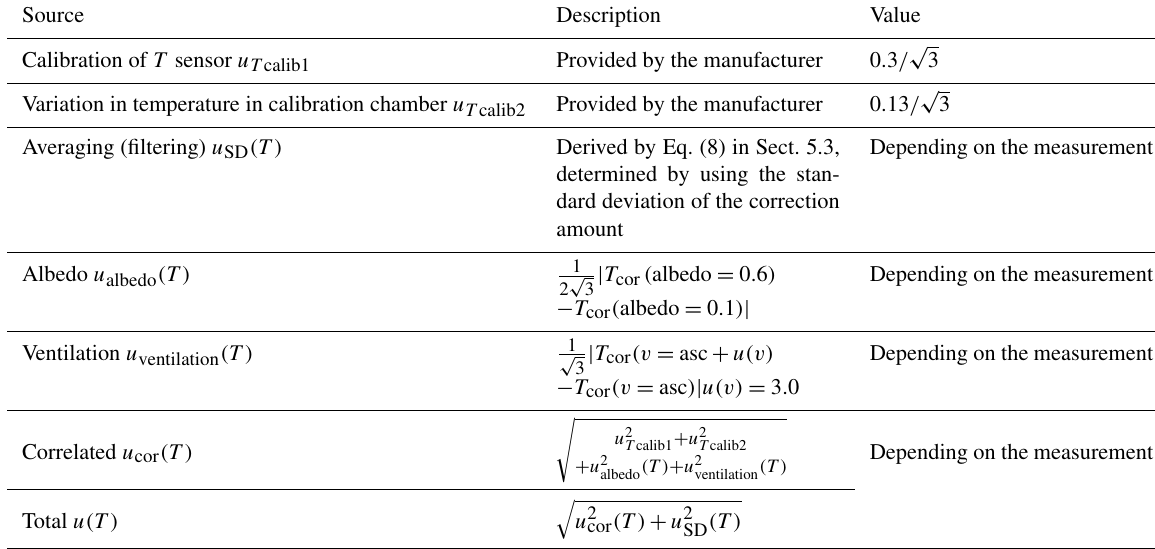
Table 6. Sources contributing to RS-11G temperature measurement